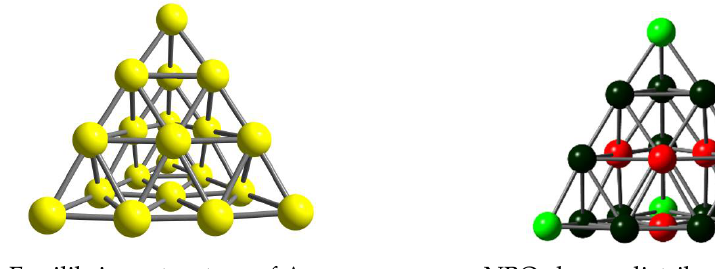
Figure 1. Geometry and NBO charge distribution in the tetrahedral Au 20 cluster. Au color range.: green, more positive than 0.06 au; red, more negative than −0.06 au.